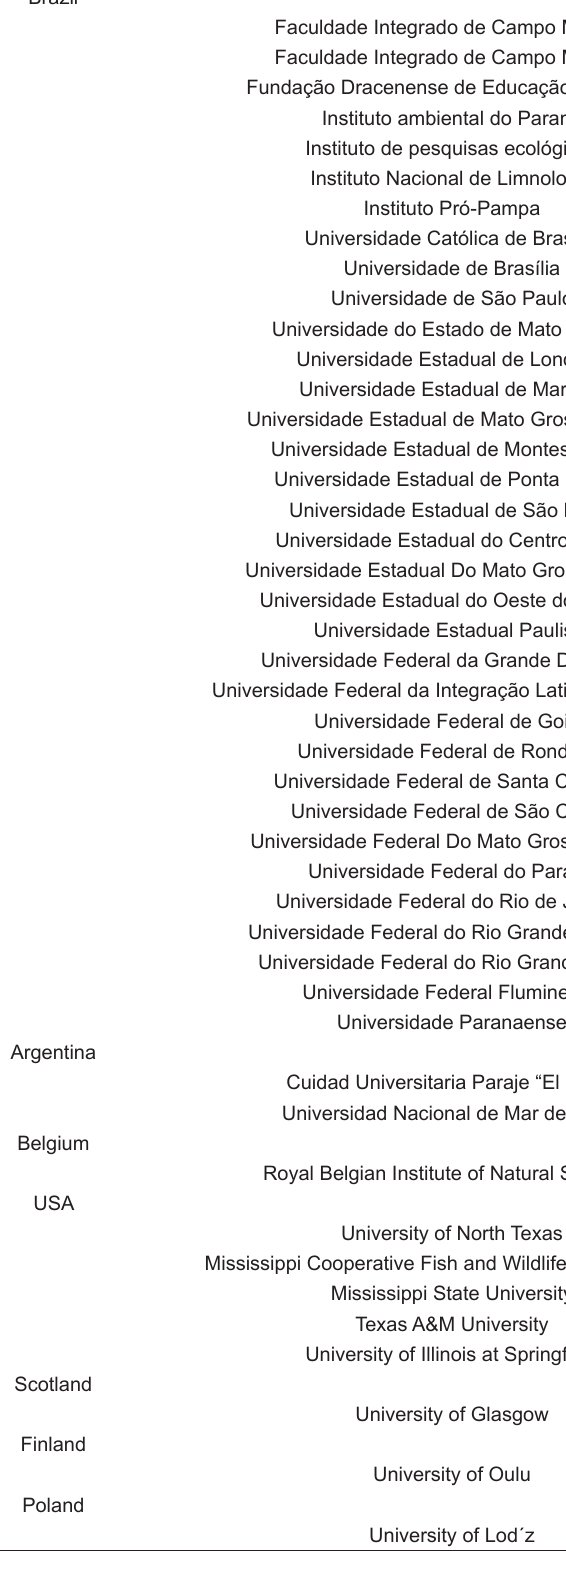
Table 1. Countries and research institutions of the articles raised in this study.